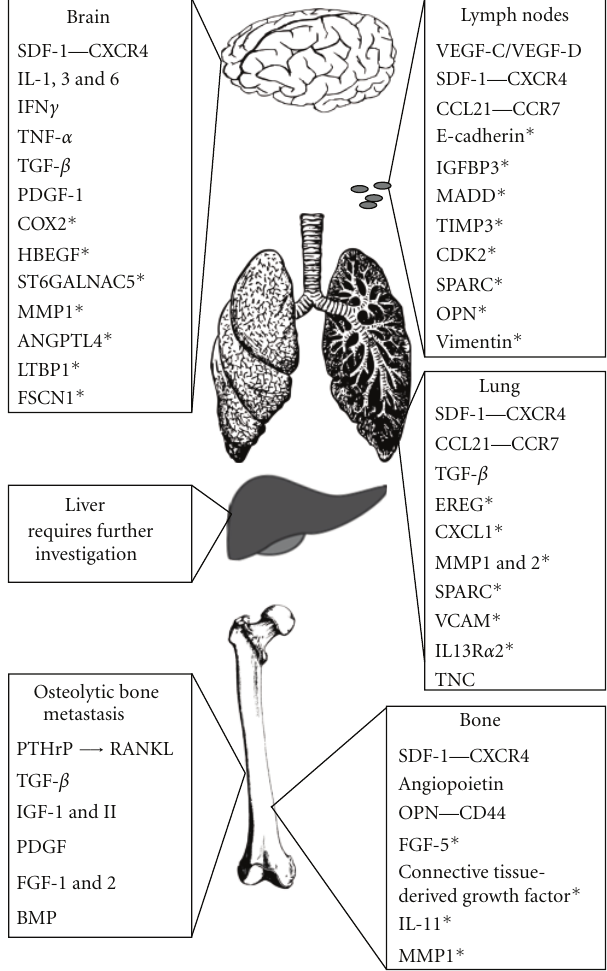
Figure 1: Potential factors involved in the organ-specific metastasis of breast cancer to the brain, liver, lymph nodes, lung, and bone. Brain, lung, and liver images were acquired with thanks to Creative Commons Licensing (CC0 1.0, Public Domain Dedica- tion). Bone image from Gray’s Anatomy (1918, Public Domain, copyright expired). Underlining indicates tumor-derived factors. Italics indicate organ-derived factors . ∗ indicates factor identified by microarray analysis of organ-specific metastatic cell line variants